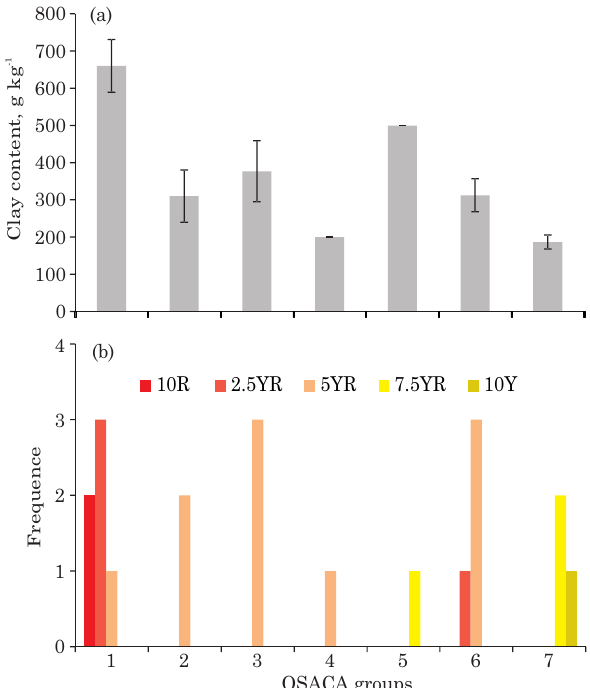
Figure 5. Average clay content and standard deviation for each OSACA group (a); and frequency of soil profile hues in the different OSACA groups (b).